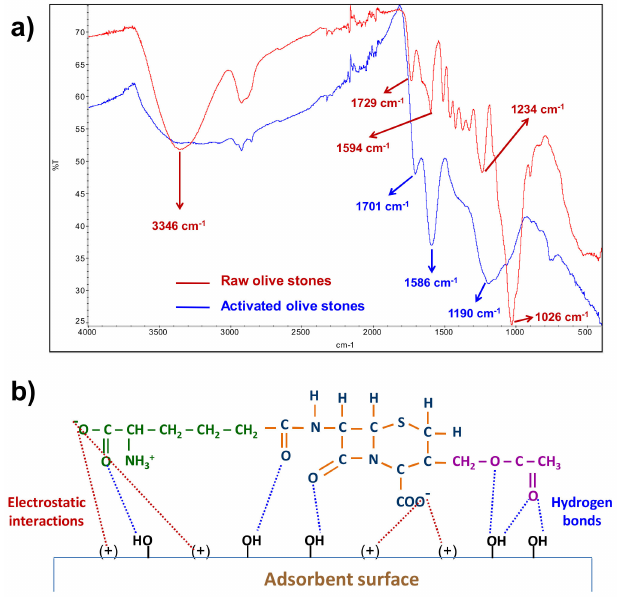
Figure 5. ( a ) FTIR spectra of raw and activated olive stones; ( b ) interactions between AOS and